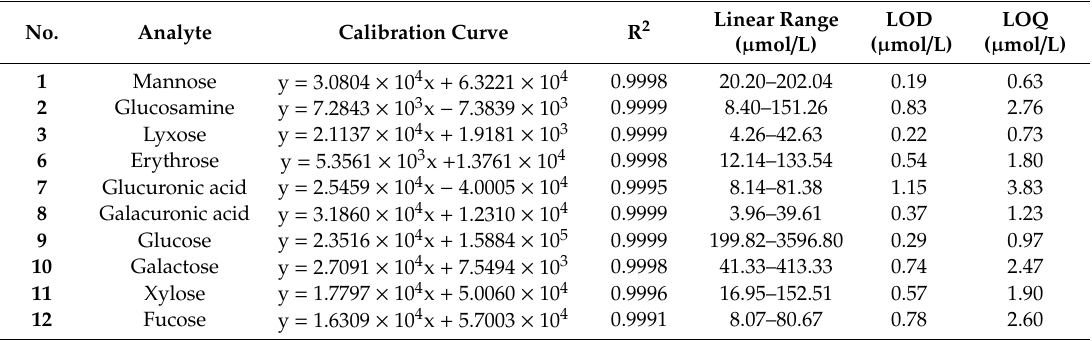
Table 2. Calibration curves, linear ranges, limits of detection (LODs), and limit of quantification (LOQs) of 10 monosaccharide derivatives.